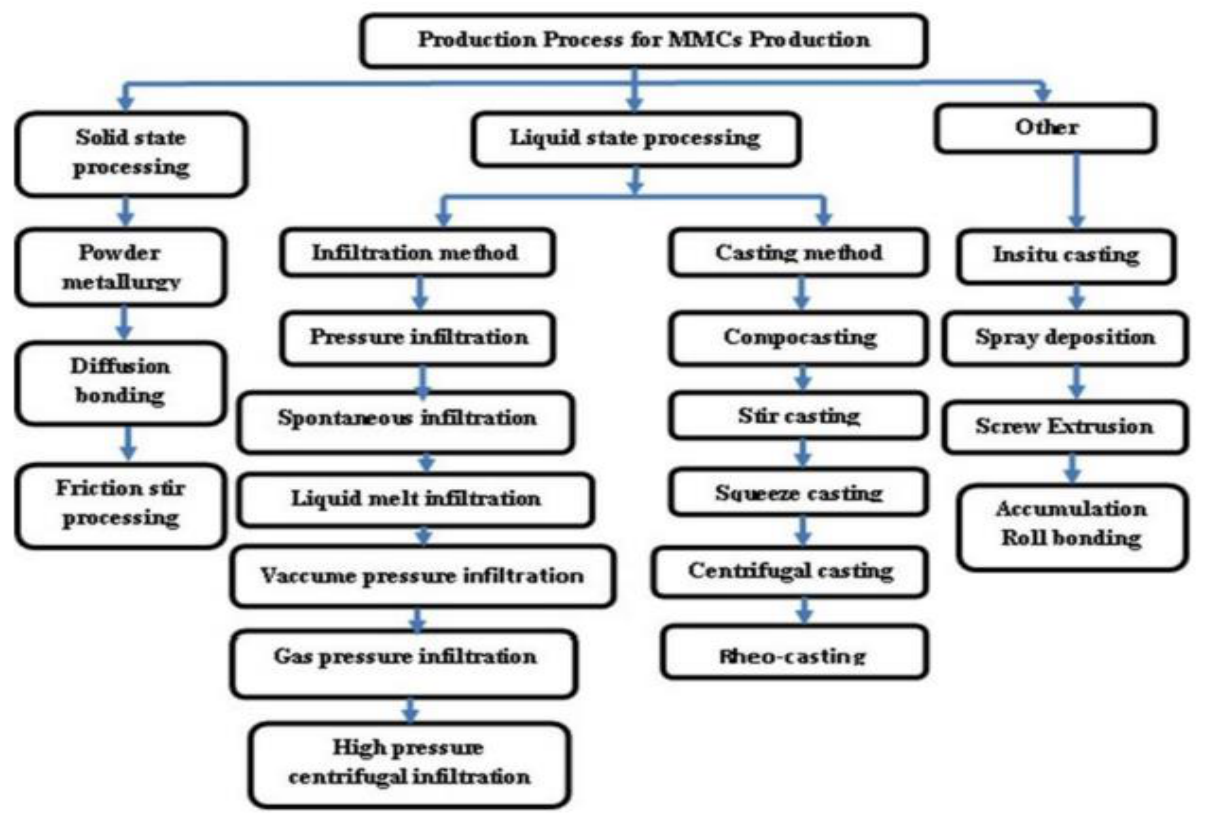
Figure 9. Stir casting system for AMMC manufacturing procedure.